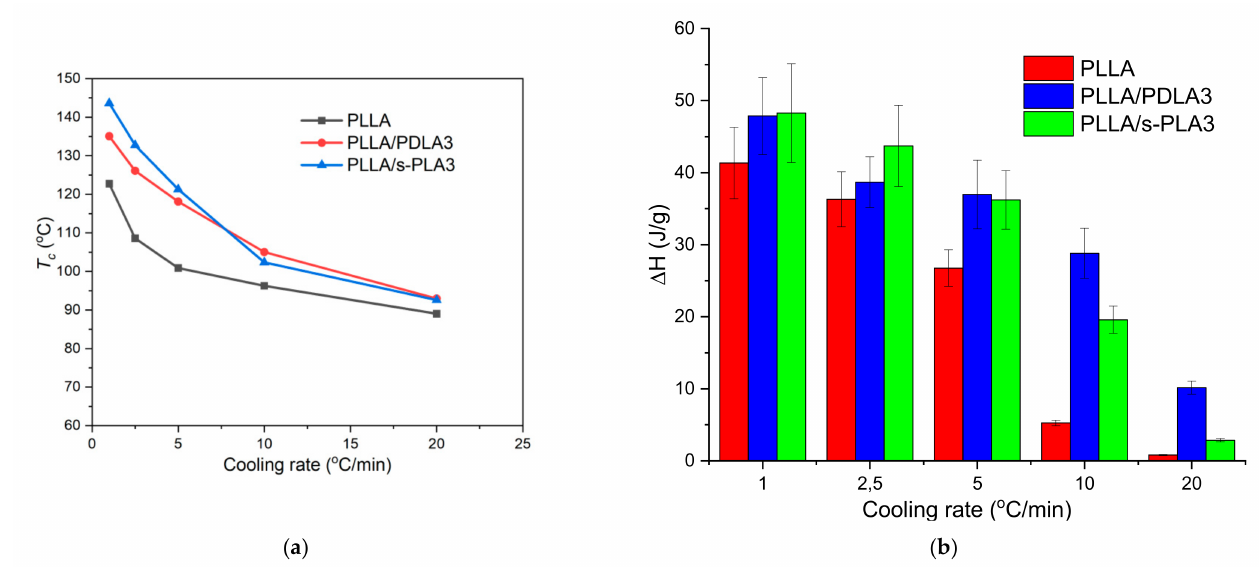
Figure 4. ( a ). Change of cold crystallization temperature ( T c ); ( b ). Heat of melting at different scan rates for PLLA, PLLA/PDL3, and